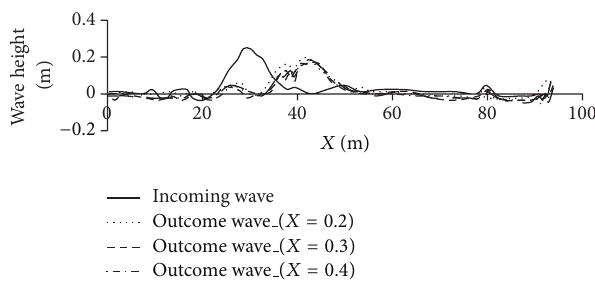
Figure 17: A view of SPH solution.